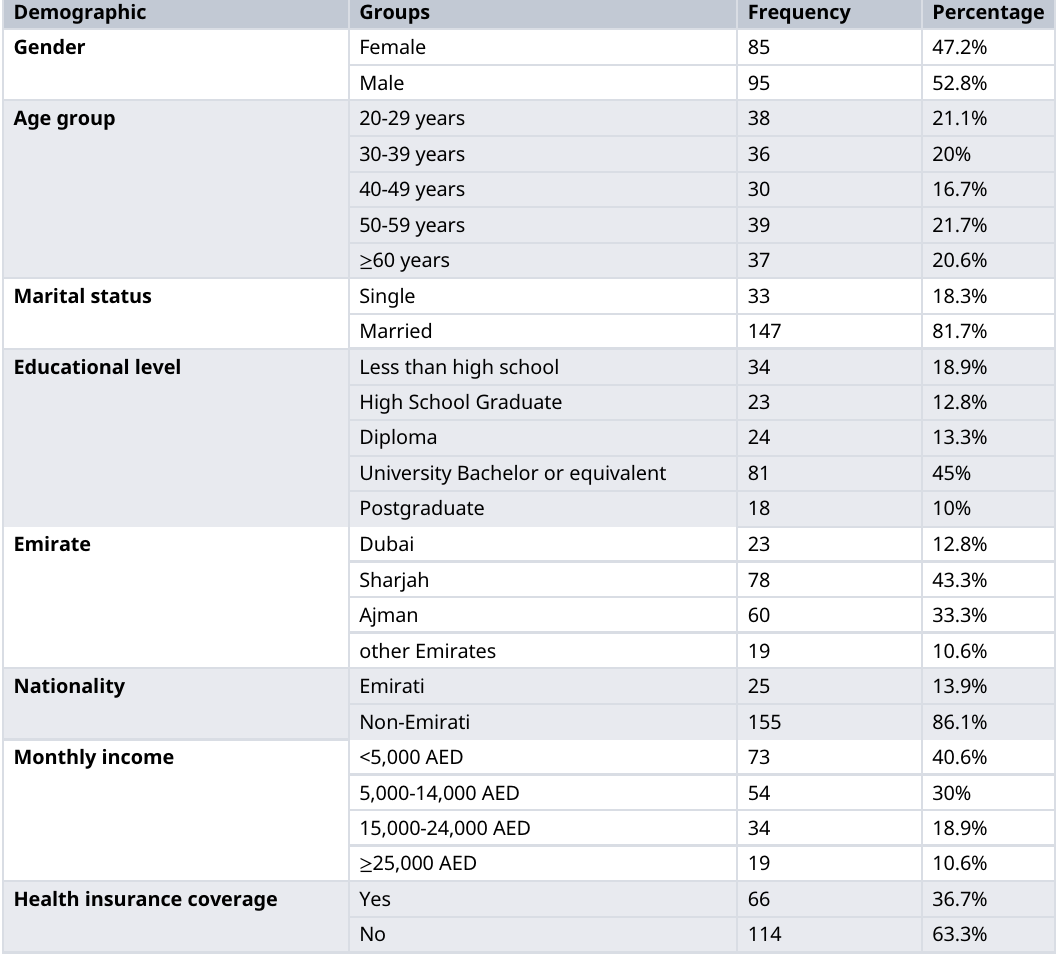
Table 1. Number and percentage of the questions on demographic information (n =